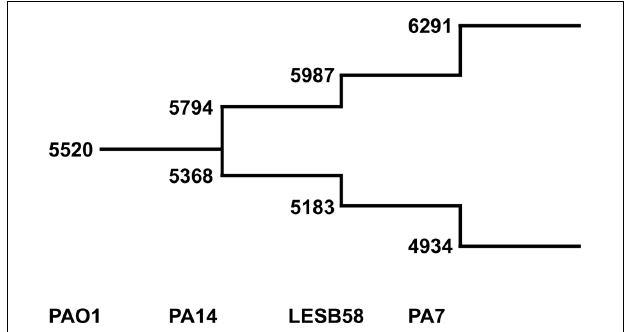
FIGURE 5 |The P. aeruginosa pangenome. The extent of the P. aeruginosa core- and pan-genome is shown as a stepwise development going along with the availability of complete genome sequences.The numbers at the lower branch give the amount of genes identified as best reciprocal blast hits in the indicated genomes (core genome). Numbers of the upper branch describe amount of genes making up the pangenome. For each genome the number of genes are added that are neither ortho- nor paralogs of genes from the existing